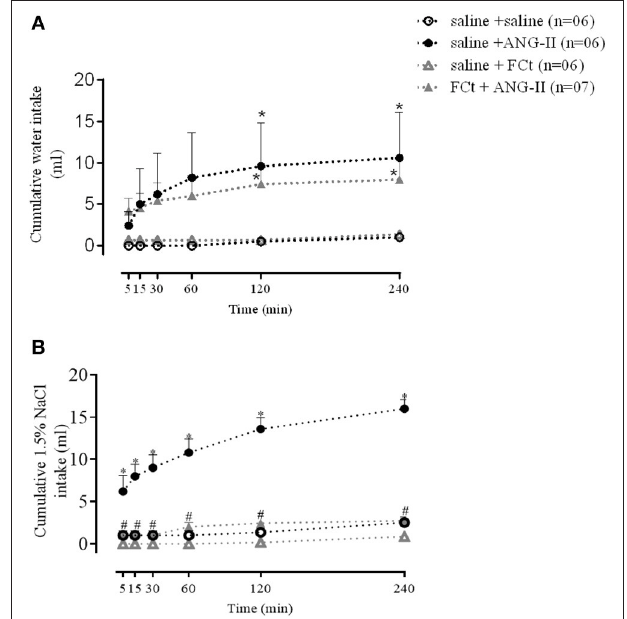
FIGURE 2 | Effect of icv saline, ANG-II or FCt microinjection on vasopressin [AVP (A) ] and Oxytocin [OT (B) ] plasma release after local saline or FCt pretreatment in awake rats. Differences among groups were calculated by One-Way ANOVA followed by the Newman–Keuls post test. Values were expressed as means ± SEM. * p < 0.05 vs. control group (saline + saline). # p < 0.05 vs. saline + ANG-II group.